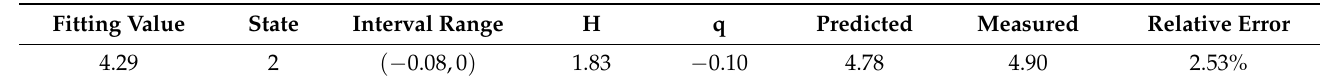
Table 14. Quantitative prediction of the sea clutter power of the latter position by the improved grey Markov model.